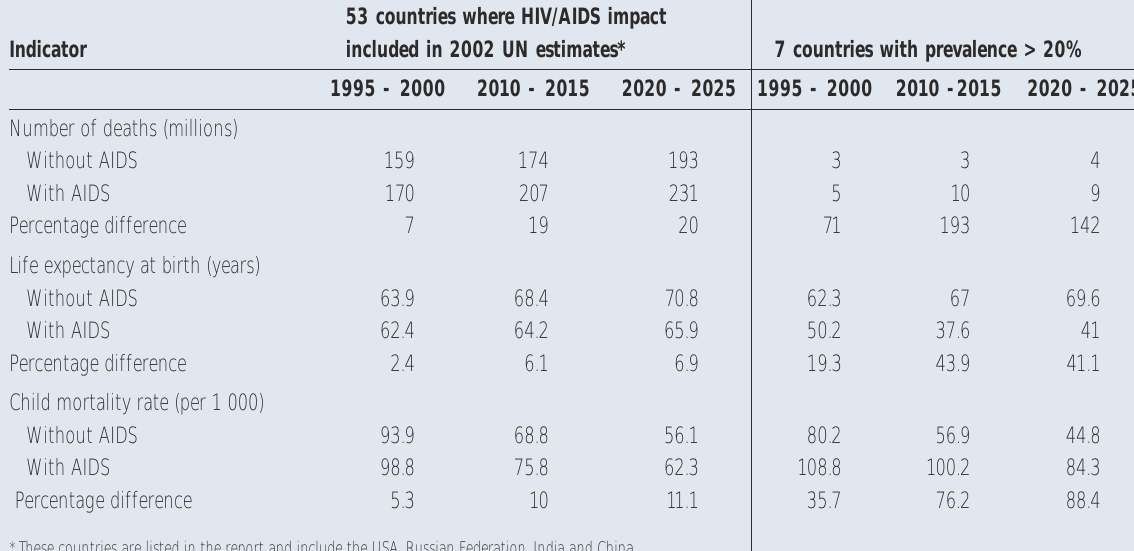
estimated that the number of births was reduced by approximately 700 000, corresponding with almost 5.9% of all births that would have occurred during the last two decades. 12 Cohort mortality may be very high. Fig. 2 looks at life- expectancy for today’s 15-year-old boys in a number of African countries. 19